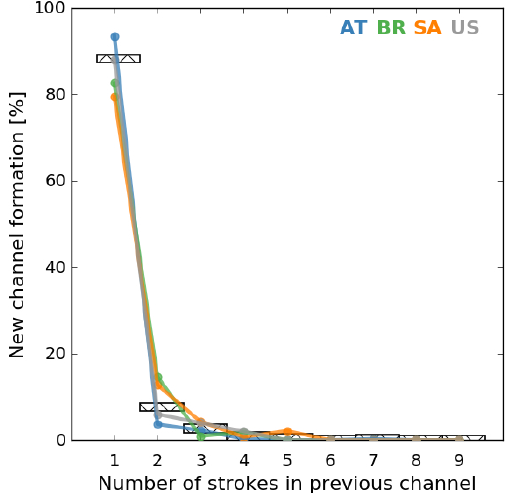
Figure 6. Relation between new lightning channel formation and the number of strokes in previous lightning channel. The shaded rectangles represent the result for the combined data sets.